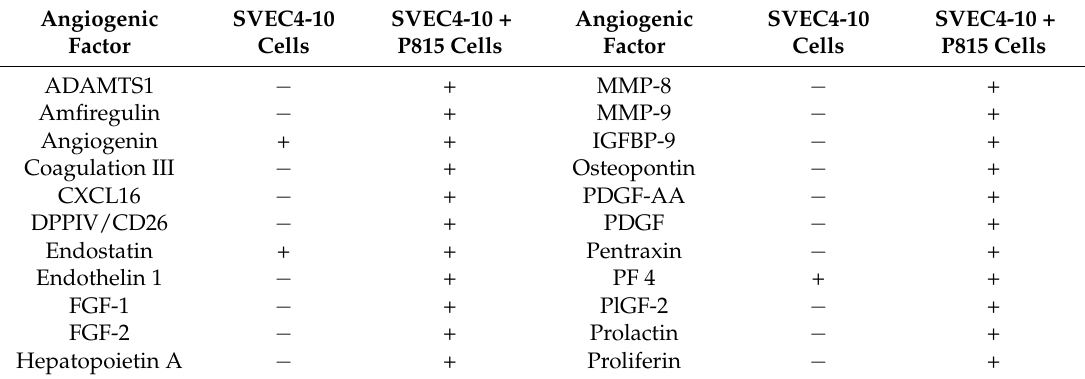
Table 1. Angiogenic factors released in the presence or absence of P815 mast cells.